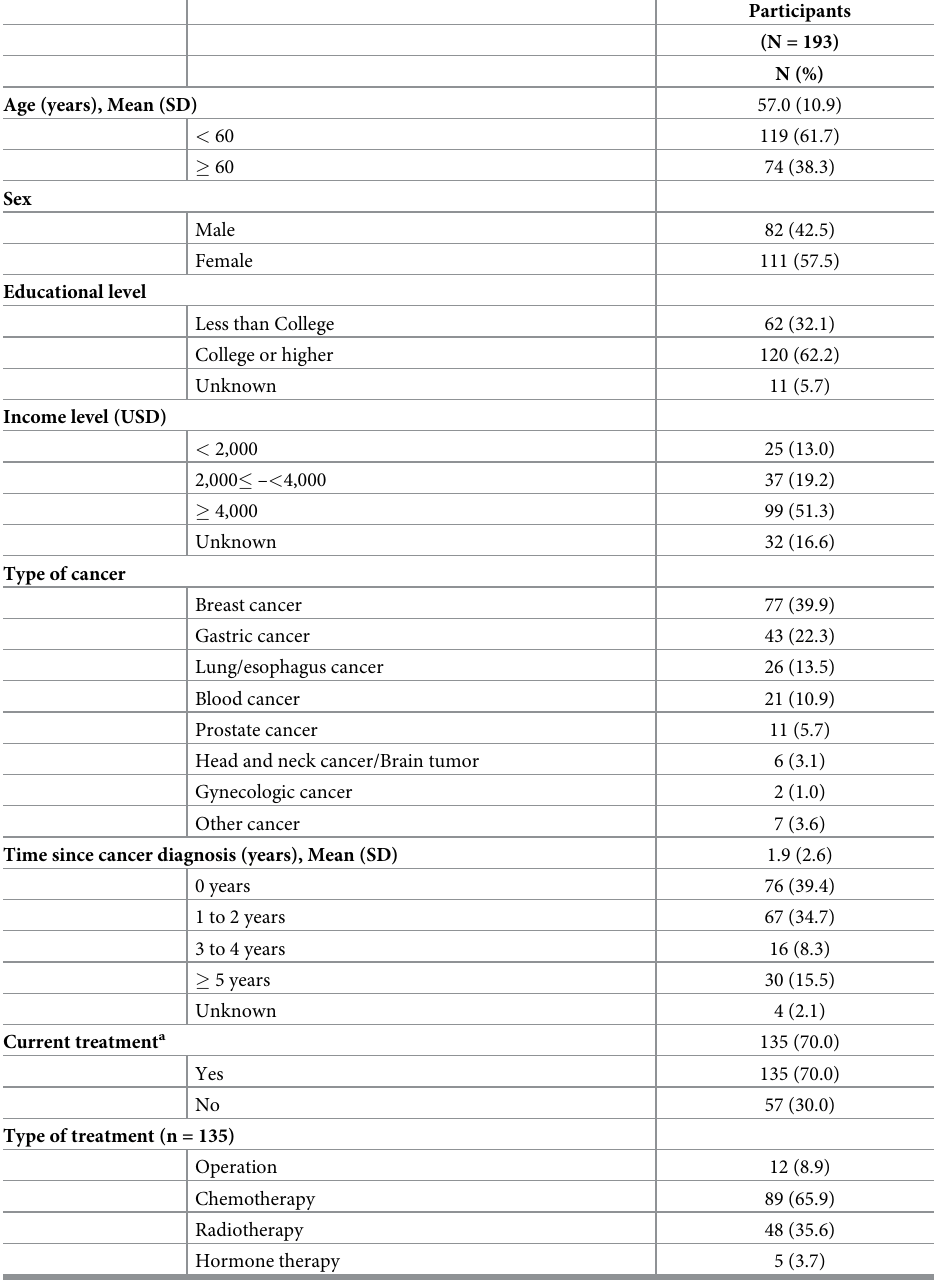
Table 1. Characteristics of the study